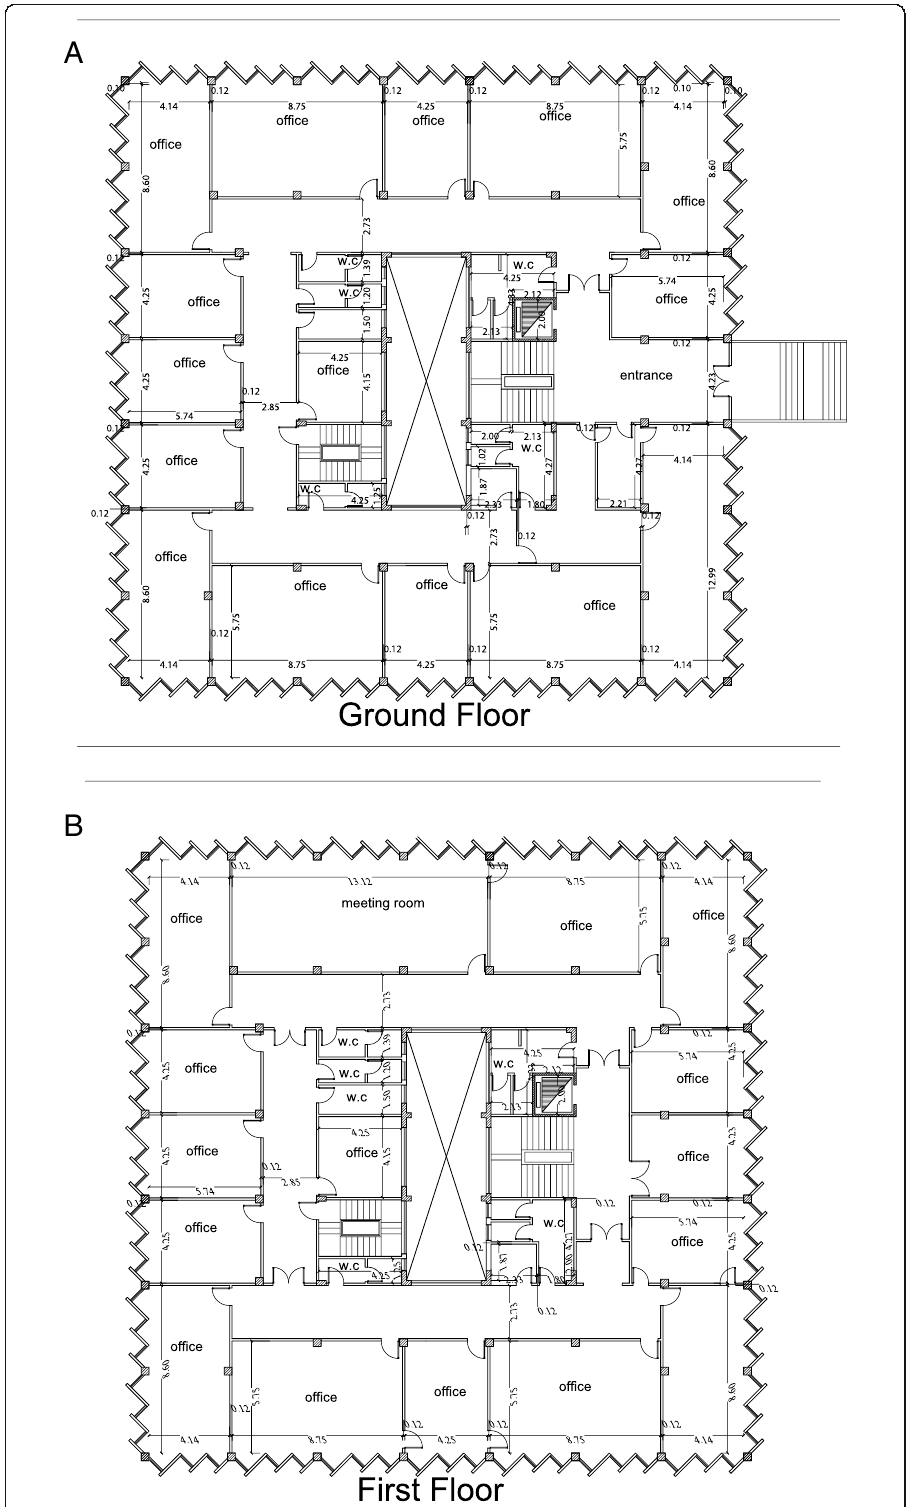
Fig. 9 Plans of Aswan University ’ s administrative building. Photo source: Architectural Engineering Department at Aswan